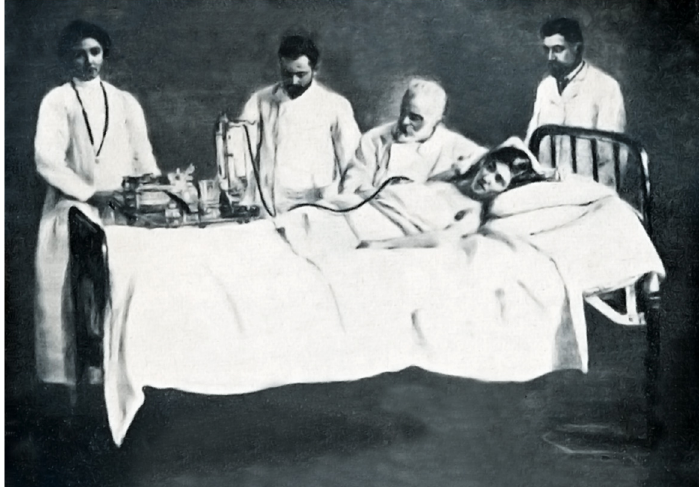
Figure 4. Carlo Forlanini while practicing artificial pneumothorax. Museum for the History of the University of Pavia.